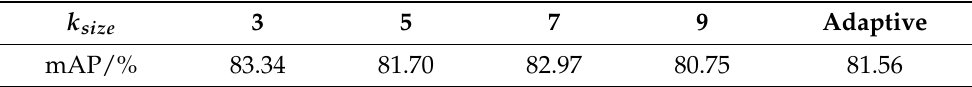
Table 5. Results of adding the ECA module to the backbone with various numbers of k size .